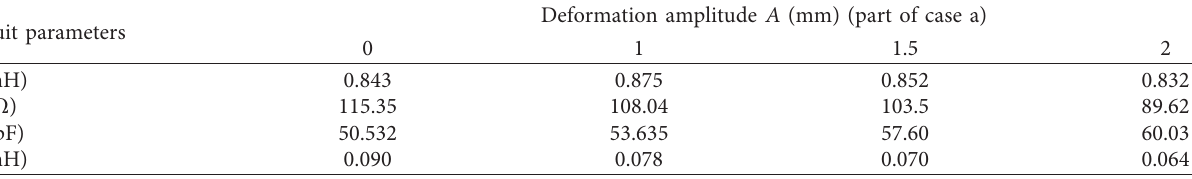
Table 3: Equivalent circuit model parameters for air microstrip antenna deformation in XOZ plane with A � 0 (the flat case), 1mm, 1.5mm, and